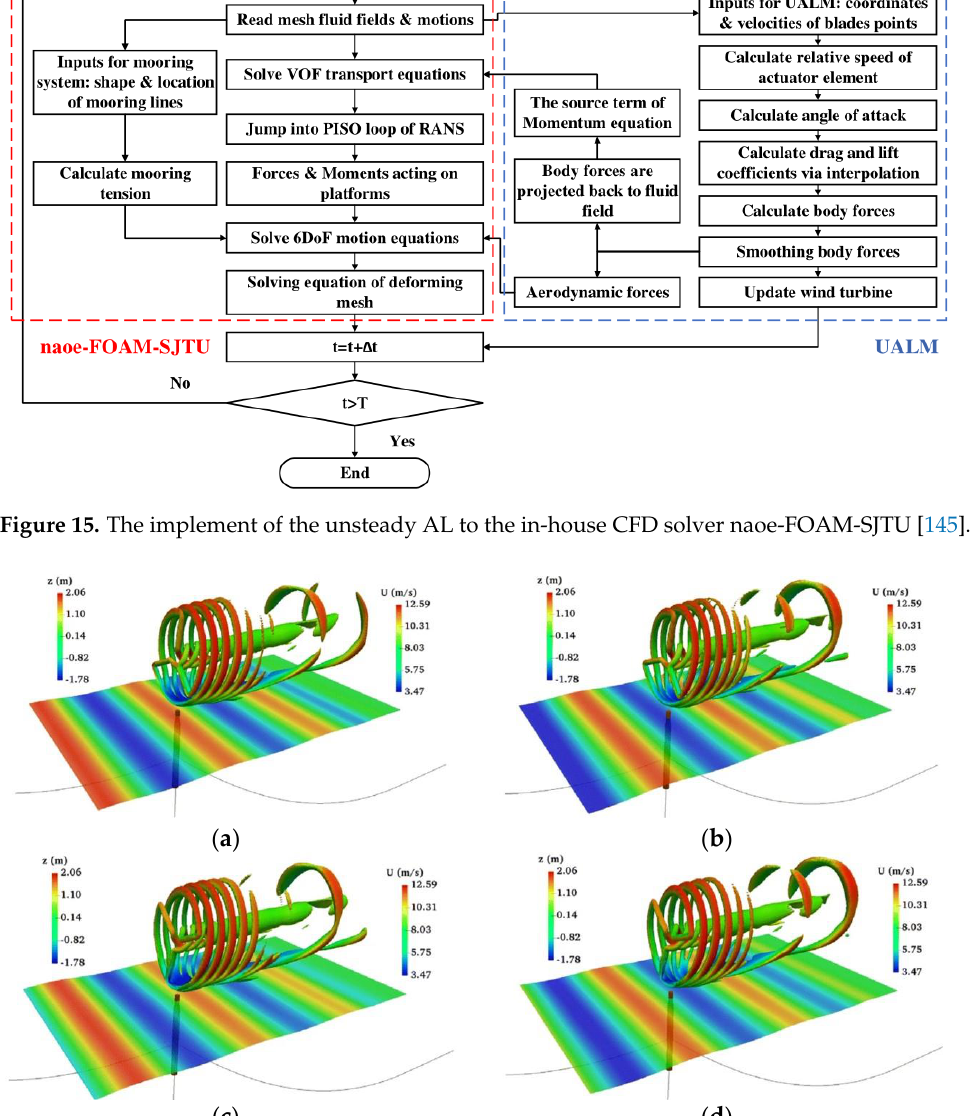
Figure 15. The implement of the unsteady AL to the in-house CFD solver naoe-FOAM-SJTU [145].